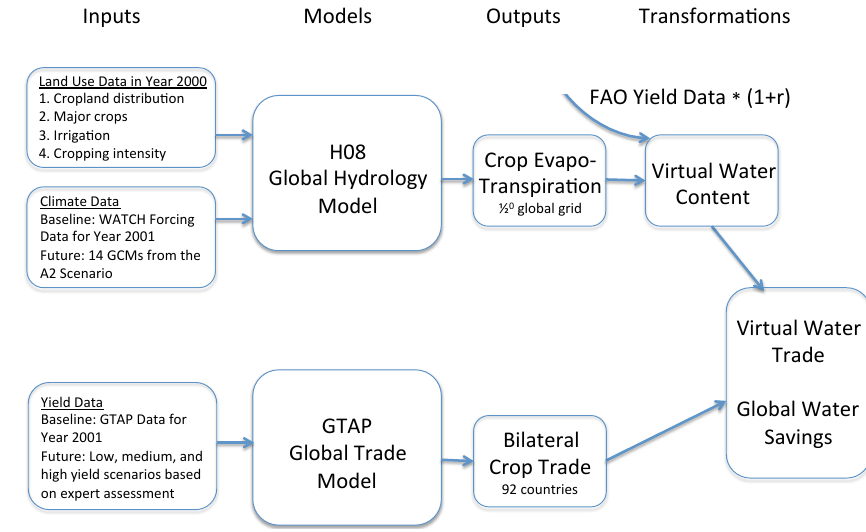
Fig. 1. Schematic of key data, models, and methodology